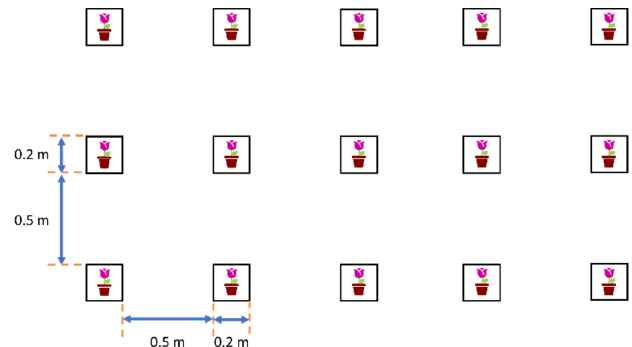
Figure 10. Distribution of roses in a matrix form. In the arrangement of plants from Figure 10, before the implementation of the FLC, the rose crop required a weekly water flow of 15.2 L in the months from June to October, this period being the one with the highest water consumption, while during November to May, the amount of water required was 7.7 L. This data corresponds to a water supply per week for the complete arrangement under weather conditions in the State of Mexico. After embedding the proposed controller in an Altera generation V card and imple- menting it in rose cultivation, the water consumed during the months of highest consump- tion was reduced to 15 L, while for the rest of the year, the required water flow was 7.5 L, thus achieving, on average, a reduction in water consumption of 0.2 L each